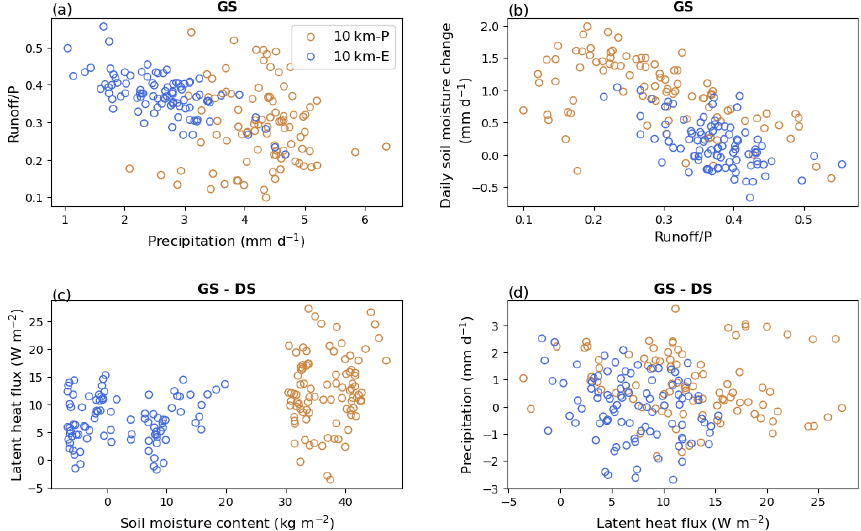
Figure B7. Relationship between different variables in the GS simulation (a, b) and the difference between the GS and the DS simulation (c, d) for the 10km-E simulations (blue circles) and the 10km-P simulations (orange circles). Each circle indicates 1d of the JAS season averaged over the WA domain outlined in Fig. 1. The panels show the following relationships: (a) the ratio between runoff and precipitation rate as a function of precipitation rate, (b) the daily change in soil moisture (within the six uppermost soil layers reaching up to a depth of 3.42m) as a function of the runoff–precipitation ratio, (c) the difference in latent heat flux as a function of the difference in total soil moisture content (again within the six uppermost soil layers reaching up to a depth of 3.42m), and (d) the difference in the precipitation rate as a function of the difference of latent heat flux.